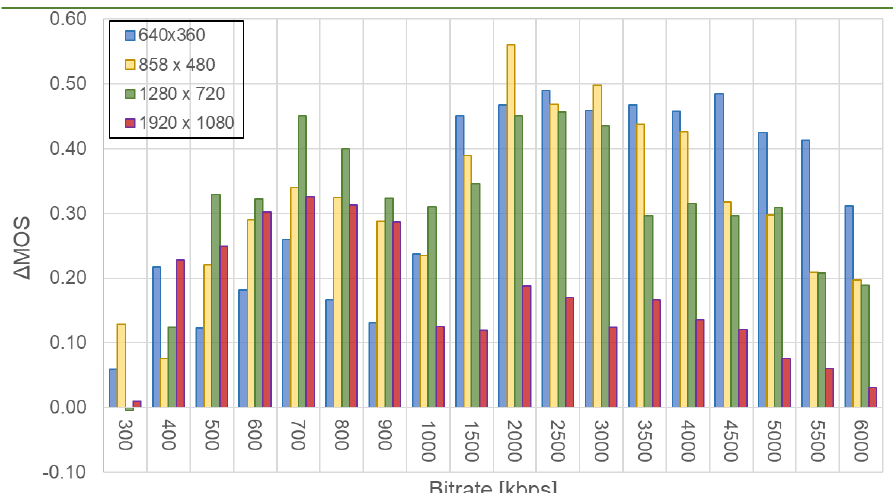
Figure 10. Difference between the results of the subjective evaluation of the H.265-encoded video (ΔMOS), conducted in the laboratory and at home, as a function of bit rate for different resolutions.